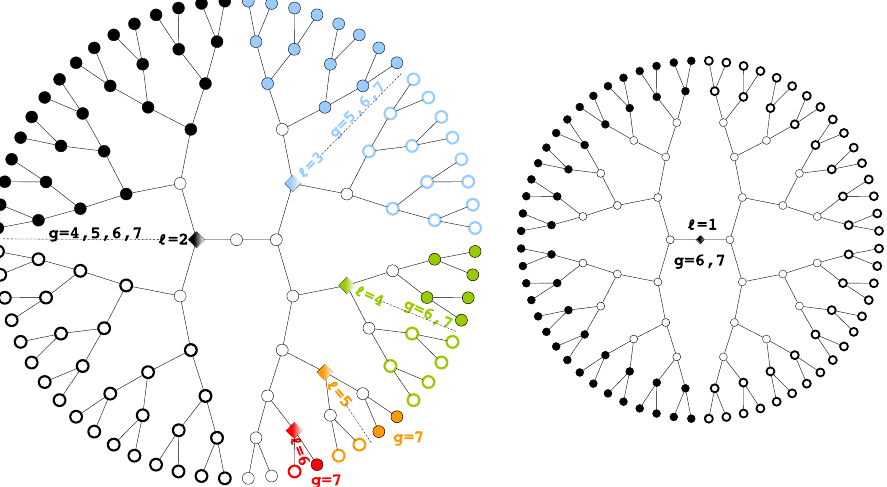
Fig 7. Bifurcated subtrees. Patterns on a tree can be described in terms of natural variables, or elemental components, examples of which are shown here. Each component is a bifurcated pattern centered on a subtree ( ℓ , τ ) and expressed in a generation g (where τ is ignored in an unordered tree). For example, the blue/non-blue bifurcated pattern occupies a subtree rooted at ℓ = 3 and observed at generations 5, 6, and 7. Note that ℓ = 1 variation (on the right) is a bifurcation across the whole pedigree. Variation among different pedigrees would be labeled with ℓ =